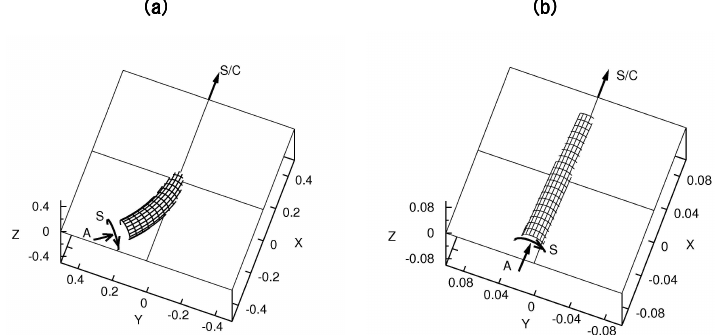
Fig. 7. Two geometries obtained for the magnetic cloud of 9 May 2001 (Event No. 14), from the fittings to the torus model (a) and to the cylinder model (b) . Note that the scales are 5 times expanded in Fig.